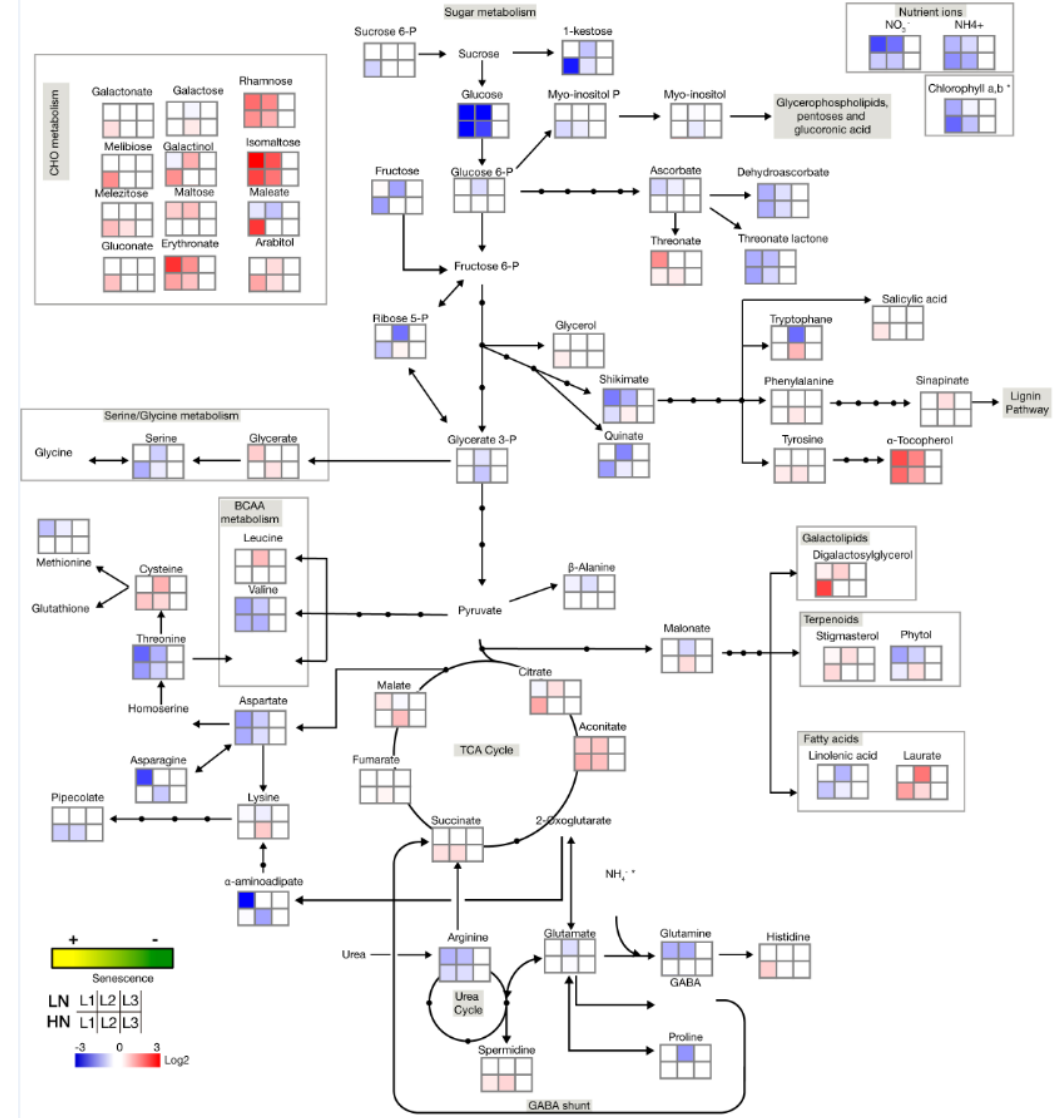
Figure 3. Heat map representation of the metabolite distribution in the three L1, L2 and L3 leaves of barley seedlings grown under LN and HN conditions. Figure 3 uses the same Log 2 Fold change values and the same false colour presentation as used in Figure 2 to represent the relative metabolite distribution in the three L1, L2 and L3 leaves of LN or HN plants. Only metabolites significantly different with senescence are shown. As in Figure 3, only senescence effect is presented, as normalization to L3 was performed separately on HN plants and on LN plants. The values range from low (blue) to high (red) metabolite-relative content compared to the youngest leaf (L3). The scale bar of red and blue shades ranges from − 3 to +3. The stage of leaf senescence is schematically indicated by shades of colours from yellow (more senescent old leaf) to green (less senescent young leaf).